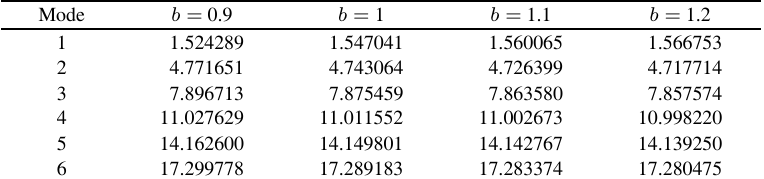
Table 6 Non-dimensional natural frequencies of clamped-free rods with A ( x ) = A 0 sin 3 ( ax + b )